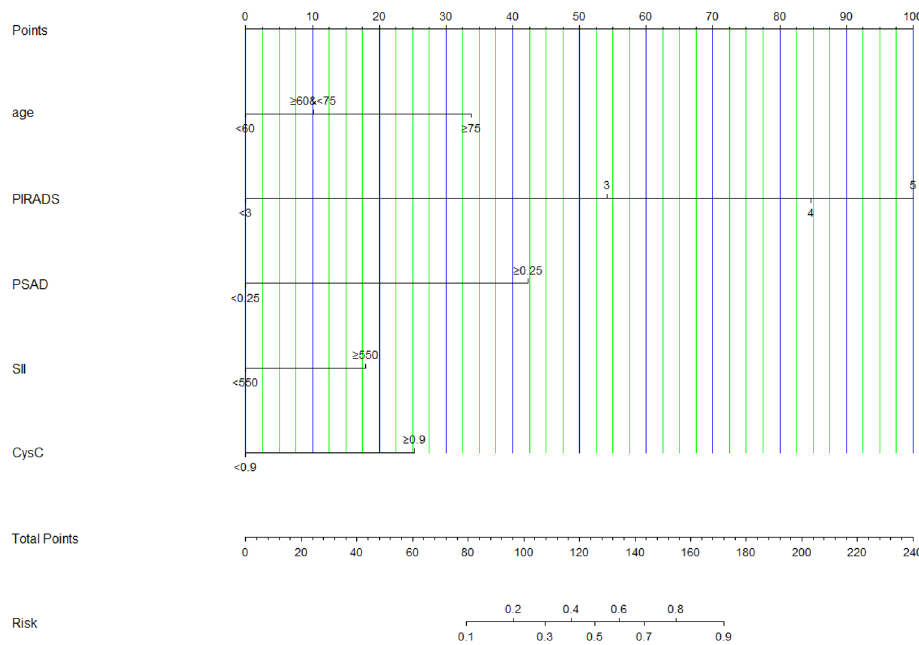
Figure 2. The nomogram for predicting the outcomes of biopsy in biopsy-naive men with PSA 4–20 ng/mL. PI-RADS Prostate Imaging Reporting and Data System; PSAD prostate-specific antigen density; SII systemic immune-inflammation index; CysC cystatin C.